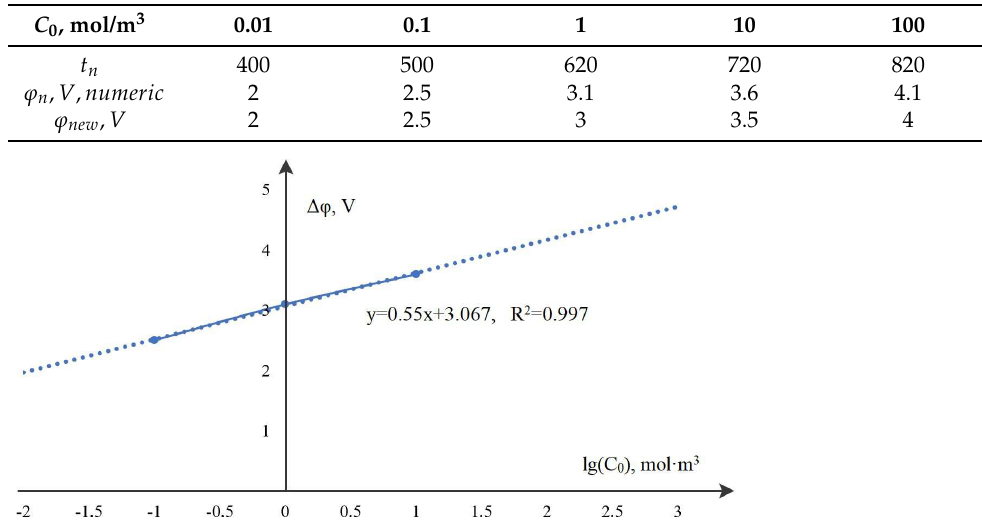
Table 1. Breakdown start time t n (potential jump, ϕ n ) depending on the initial concentration of the KCl solution.